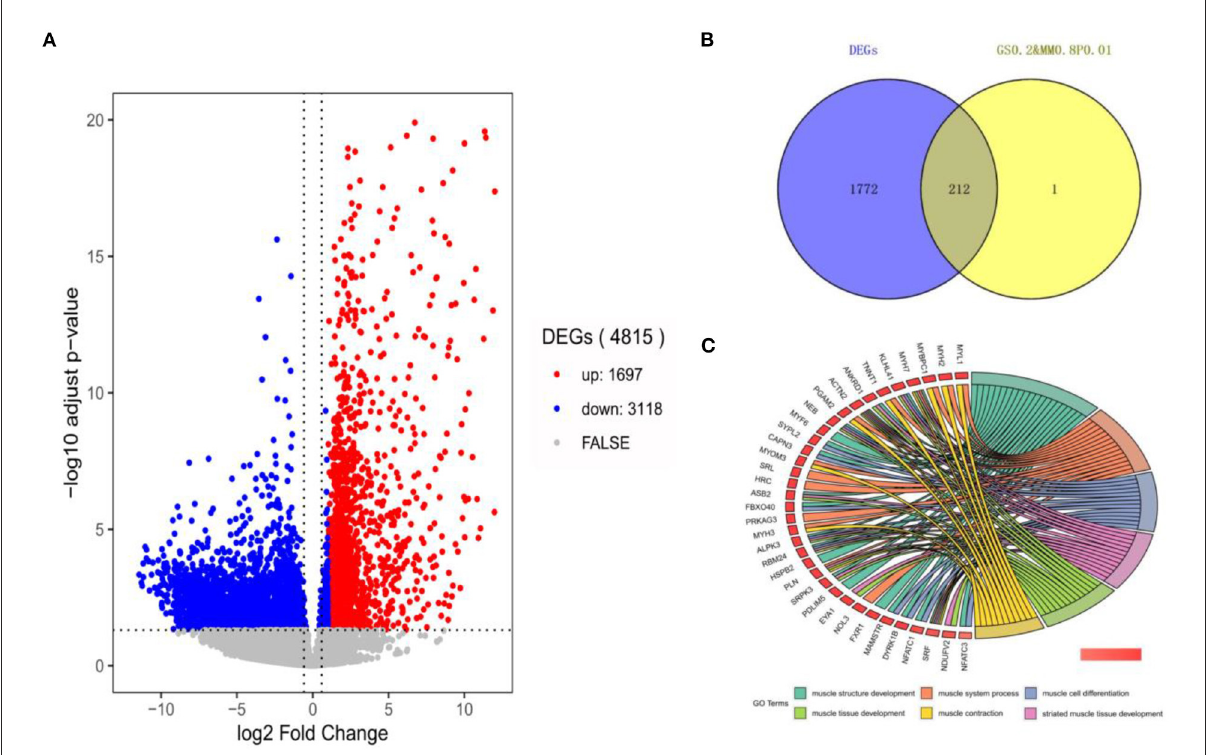
FIGURE4 The analysis of DEGs by RNA-seq. (A) The volcano-plot of DEGs; (B) The overlap-plot of DEGs and candidate hub genes in MElightyellow; (C) The top 6 GO terms with the high significance of 212 candidate hub genes.